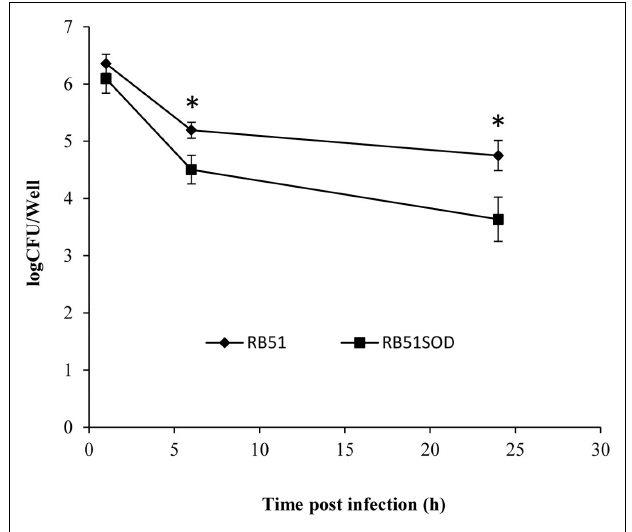
FIGURE 3 | LDH release as a measure of macrophage cell death induced by infection of RB51 or RB51SOD. The data represent the means ± SD from three independent experiments, each with an MOI of 200.The sign ∗ represents statistical significance ( P -value <